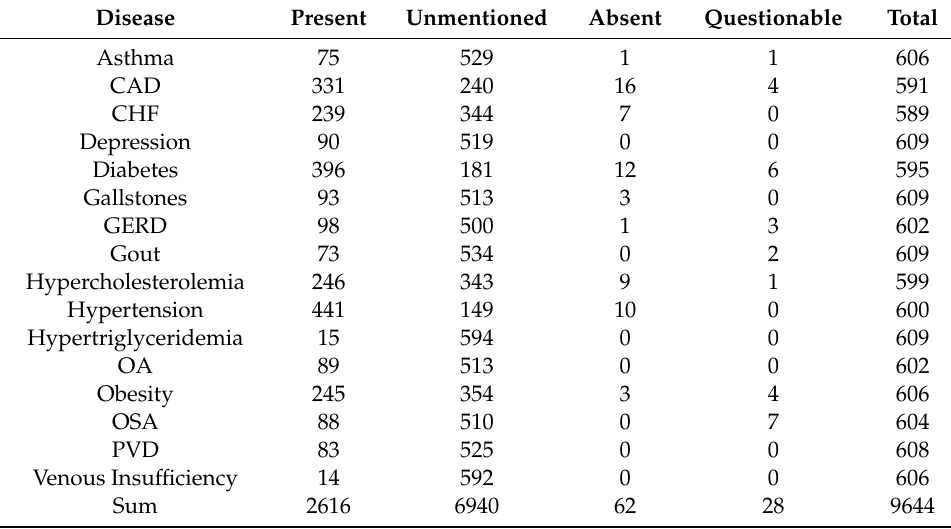
Table 1. Statistics of i2b2 obesity corpus.